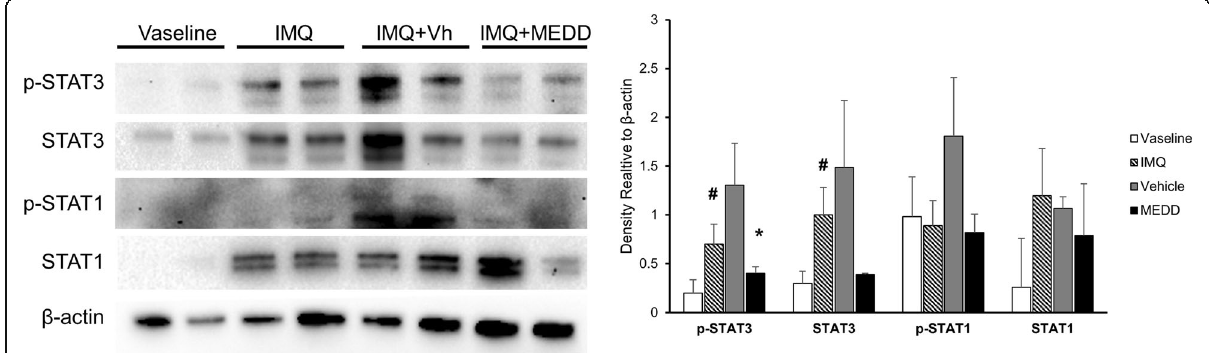
Fig. 4 MEDD effects on STAT1 and STAT3 in IMQ-induced psoriasisThe dorsal skin of mice was treated with Vaseline, IMQ, IMQ and Vh or MEDD for 7 days, and the immune cell population was analyzed by Western blotting in the skin lysates the next day. (left) Antibodies specific for pSTAT1, STAT1, pSTAT3, STAT3, and β -actin were used. Western blot performed on four samples per group. Among them, two samples per group were selected and are presented as representative images. (right) Densitometry quantification of proteins. Arrow indicates 86 (upper) and 79 (bottom) kDa size. These results represent mean ± S.D. of four independent experiments. Statistical analysis was performed using Student ’ s t -test. * p < 0.05, compared with mice in the IMQ- and vehicle-treated groups; #, p < 0.05 compared with Vaseline control mice; IMQ, imiquimod; Vh, Vehicle; MEDD, methanol extract of Dictamnus dasycarpus root